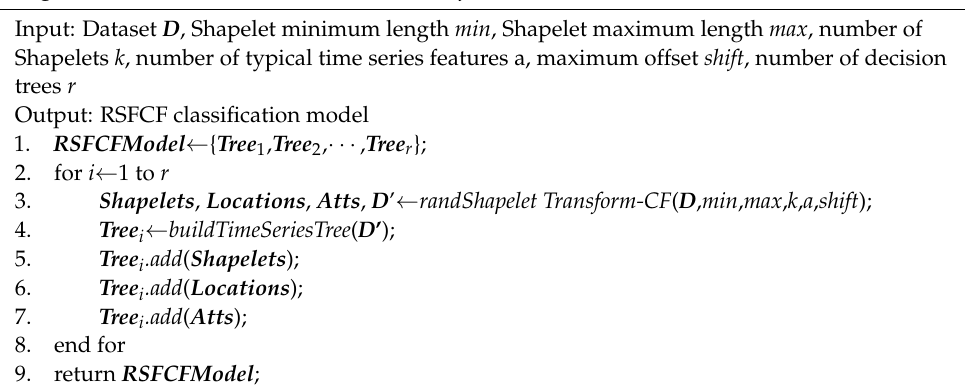
Algorithm 3. buildRSFCF ( D , min , max , k , a , shift , r